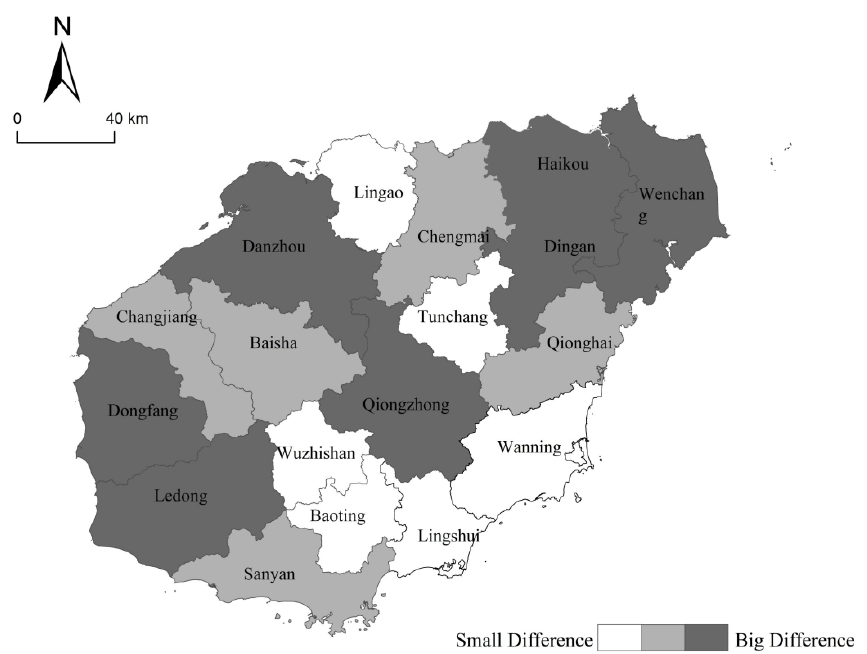
Figure 7. Comparison of ESV differences between cities and counties on Hainan Island under two assessment